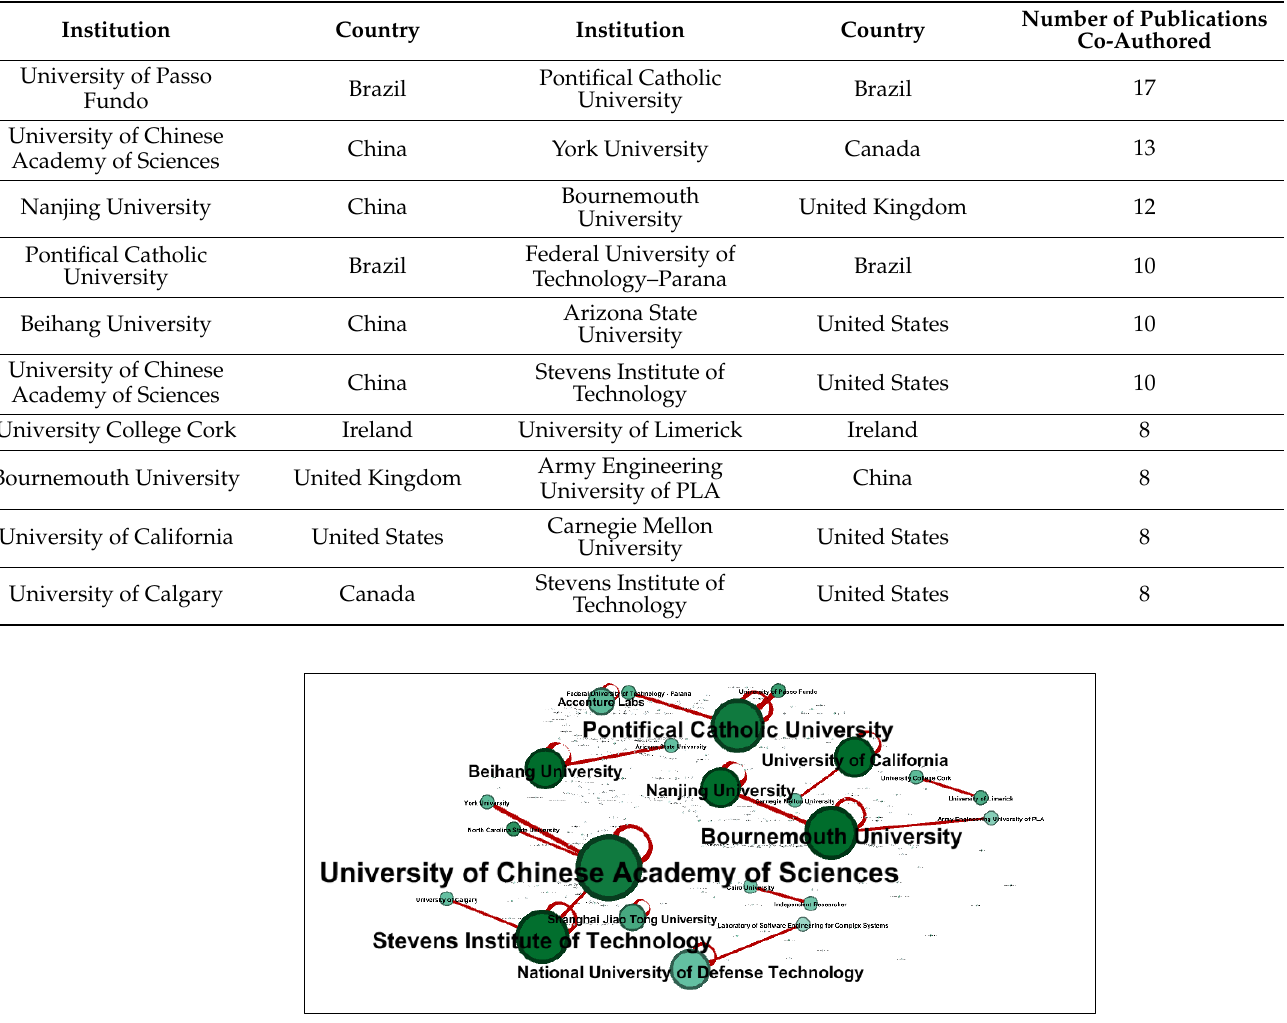
Table 10. Institutions involved most frequently in co-authorships.